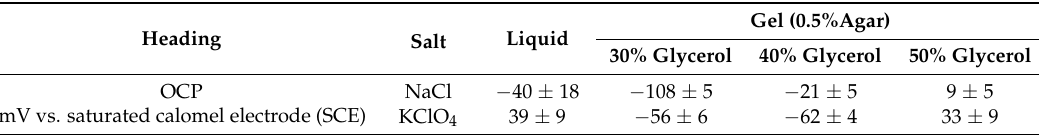
Table 2. Open-circuit potential (OCP) values obtained for AISI 304 stainless steel in various electrolytes with 0.5% NaCl and 1% KClO 4 .